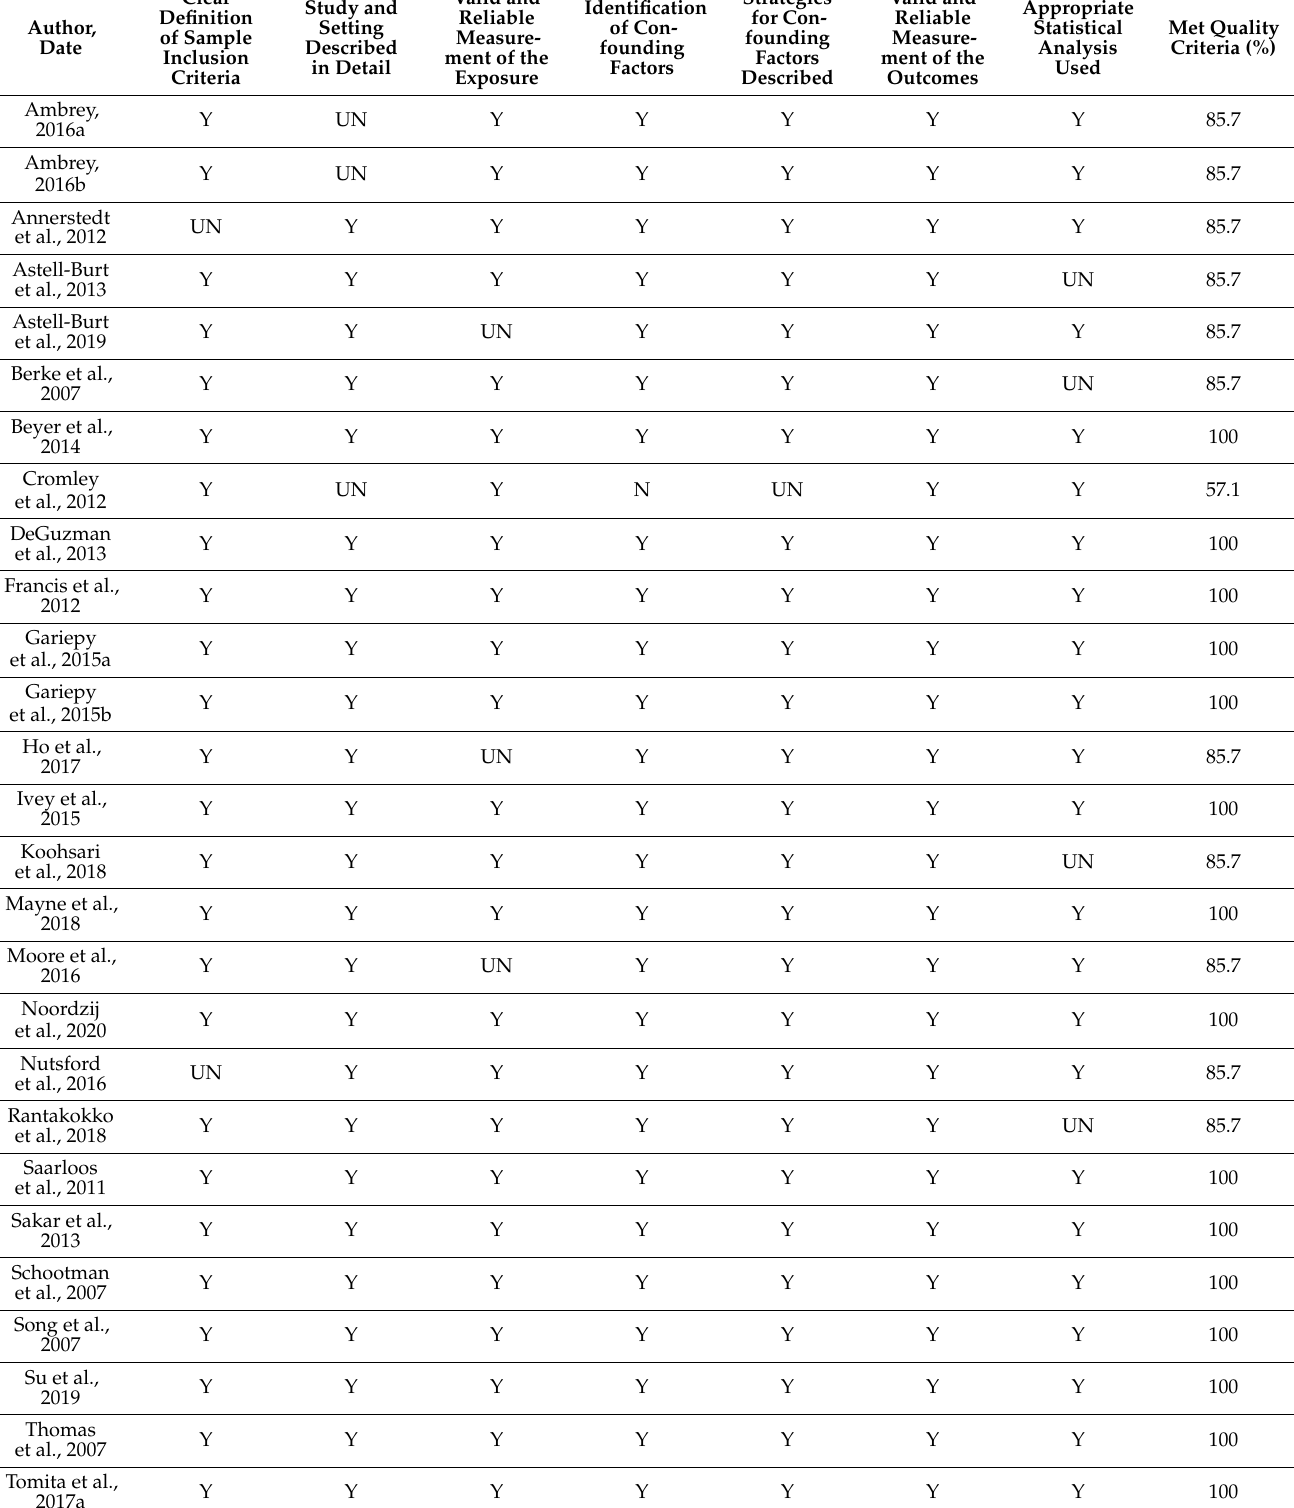
Table 1. Summary of methodological quality of included